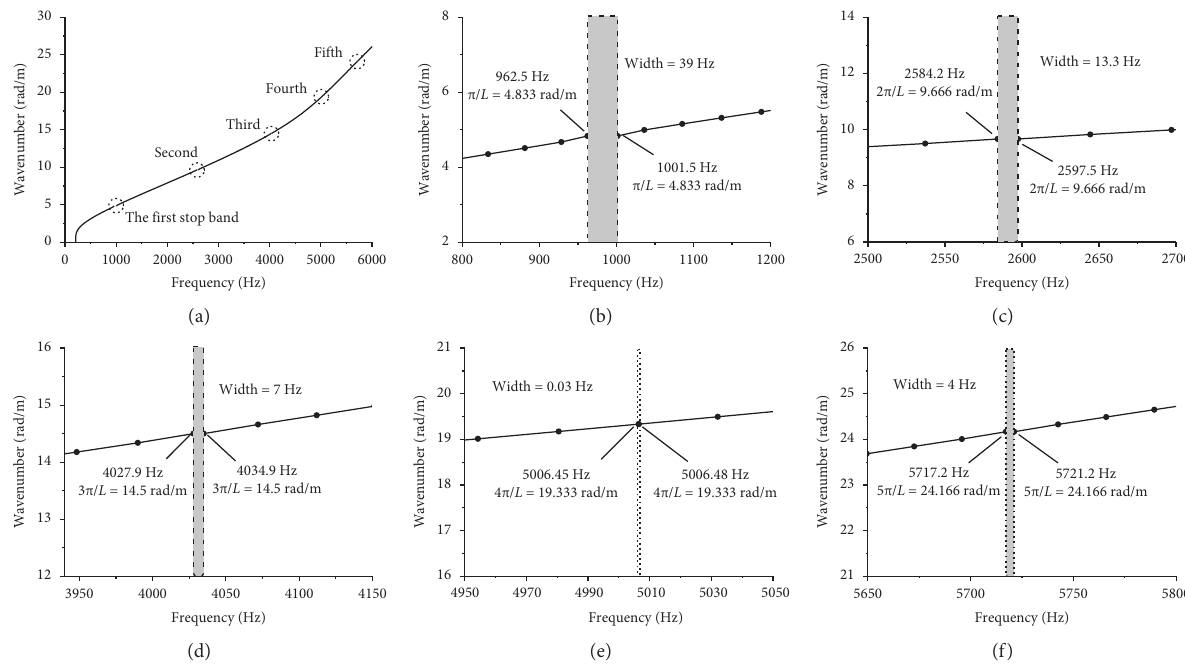
Figure 8: The dispersion curves and stop bands of the wave B : (a) the dispersion curves; (b–f) the first to fifth stop